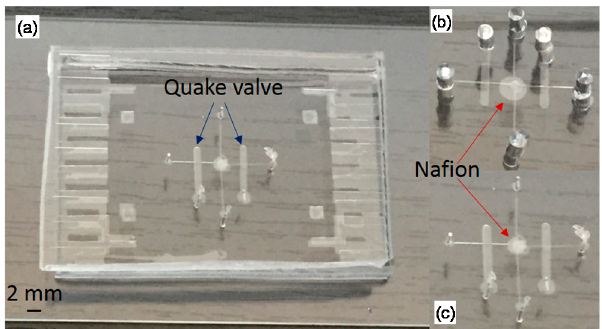
Figure 12. 3 microfluidic neuron devices. For the device ( a ), the scale is 2 mm. For these three devices, the Nafion membrane is 10 µm width. For ( a ) and ( c ), holes are 0.5 mm in diameter. For ( b ), holes are 2 mm in diameter. The fluidic channel for these devices are 100 µm × 10 µm. The Quake valve are 500 µm × 50 µm. The PDMS membrane is 10 µm in width.